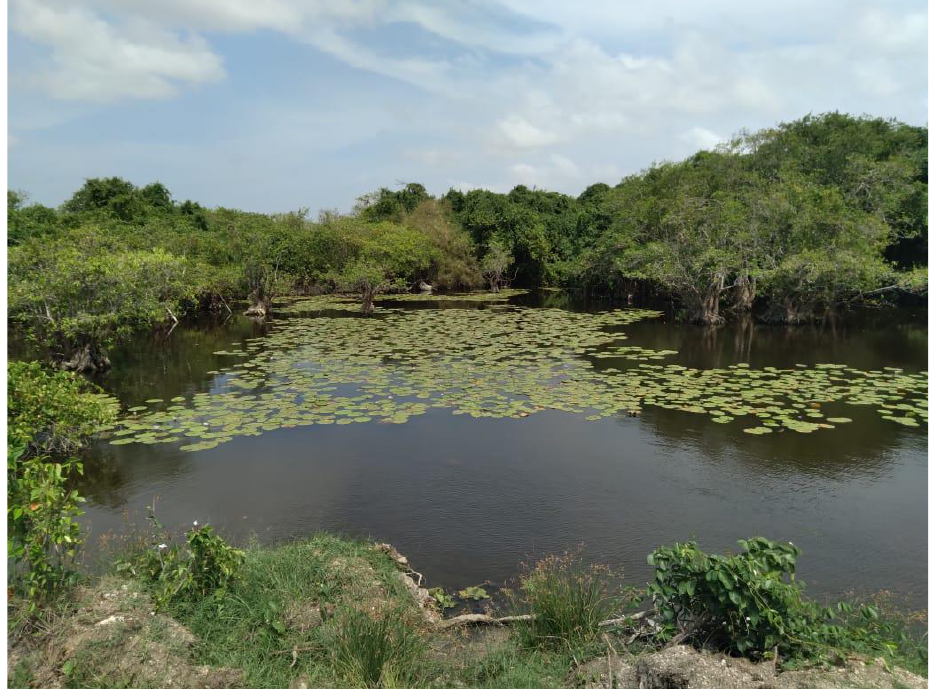
Figure 2. The waterlogged habitat in the Sarasalai proposed mangrove forest.